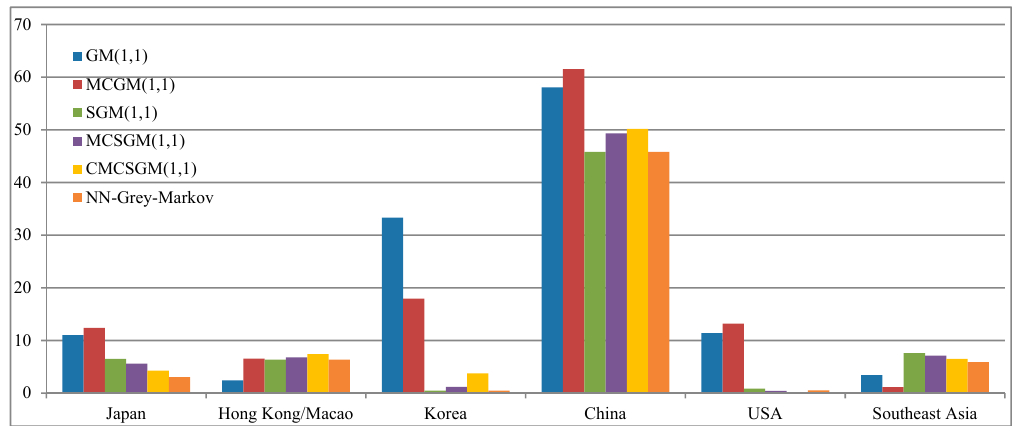
Figure 1. Model-fitting results for Case I.